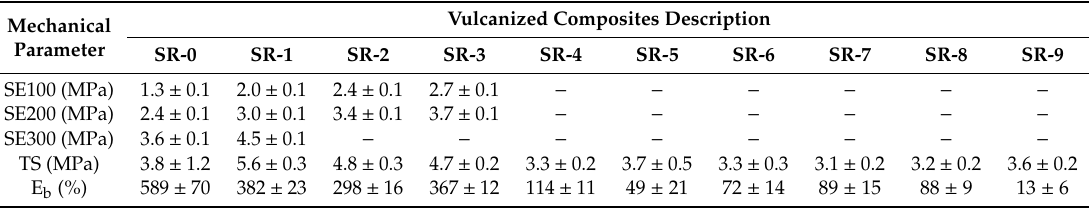
Table 7. Mechanical properties of the studied composites.